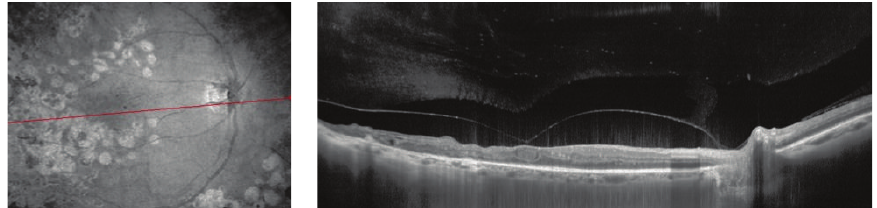
Figure 4: VPA associated with vitreomacular adhesion in diabetic retinopathy. Clear evidence of posterior precortical vitreous pocket at enhanced HD line